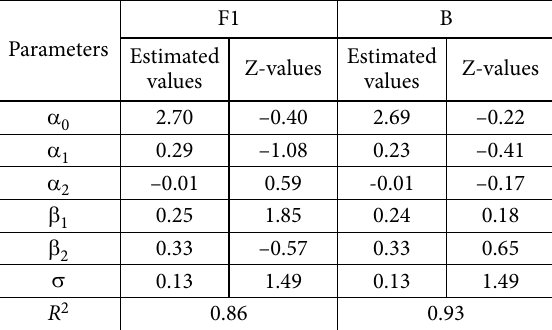
Table 2. Model estimation results for the decreased